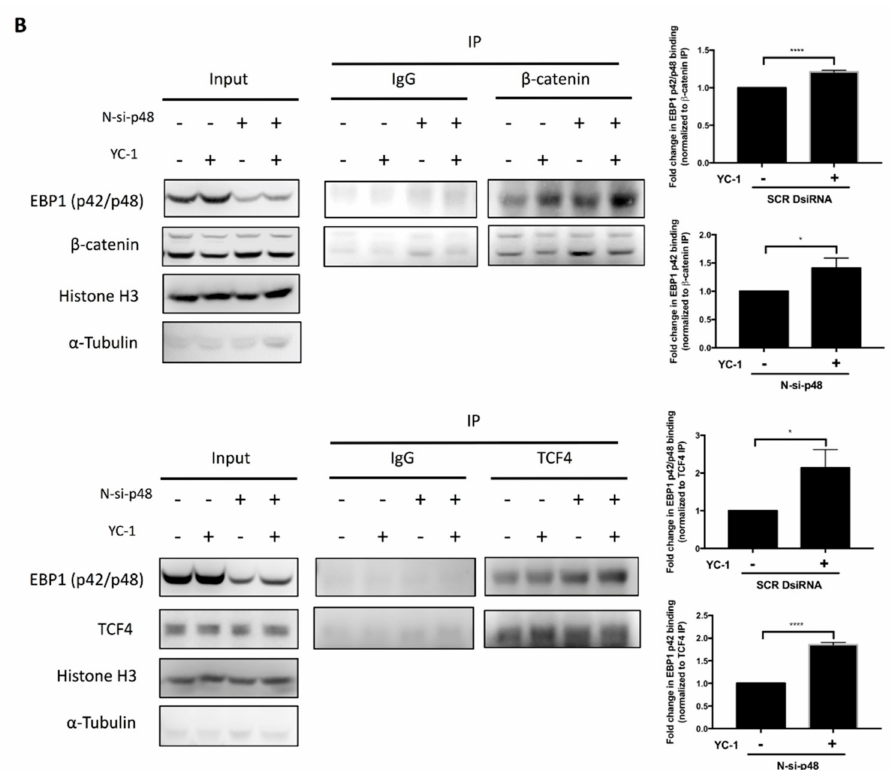
Figure 4. YC-1 enhanced the interaction of EBP1 p42 with the β -catenin / TCF complex in HCC cells. HepG2 and Hep3B cells were treated with the IC 50 of YC-1 for 6 h. The nuclear complexes containing the EBP1 isoforms were precipitated by anti- β -catenin and anti-TCF4 antibodies. The anti-N-EBP1 antibody is specific for p48, whereas the anti-EBP1 antibody recognizes both the p42 and p48 isoforms. The immunoreactive bands detected by the anti-EBP1 antibody are considered the sum of the p42 and p48 bands. The levels of EBP1 isoform binding to β -catenin and TCF4 were measured by western blotting ( A ). N-si-p48 DsiRNA targeting p48 was transfected into HepG2 cells for 24 h. Under conditions of p48 depletion alone, the interaction of EBP1 (p42 / p48) with the β -catenin / TCF complex was confirmed in HepG2 cells treated with or without YC-1 (1.54 µ M). The binding capability of nuclear p42 was detected by co-IP and western blotting ( B ). * p < 0.05, **** p <